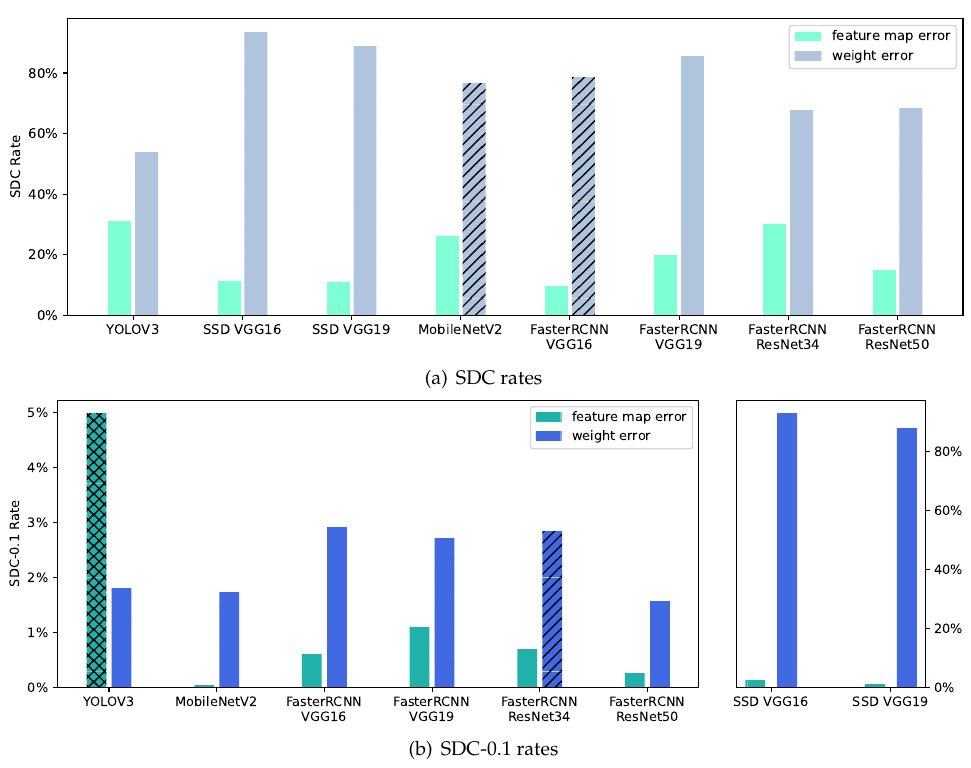
Figure 3. Feature map error and weight error injection test results for various detectors: (a) shows SDC rates for detectors under test; (b) shows SDC-0.1 rates for detectors under test. SSD detectors report extremely high SDC-0.1 rates for weight errors so the results are shown with a different scale.